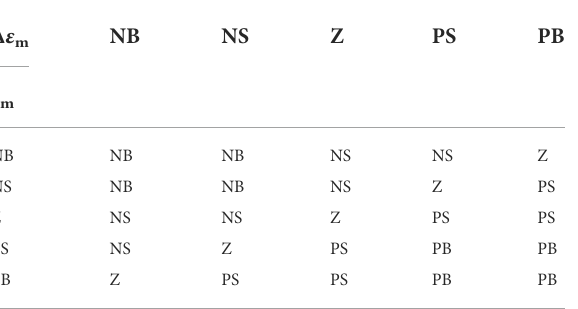
TABLE 1 Fuzzy logic rules.